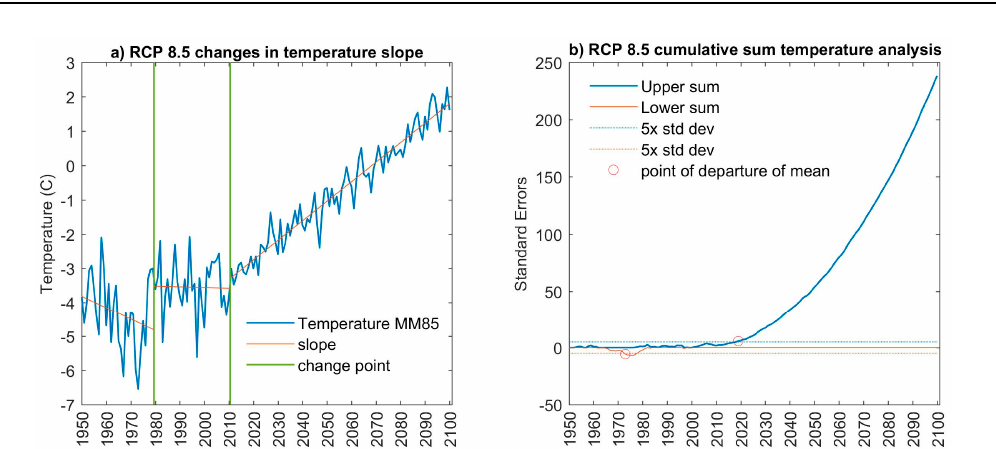
Figure 9. Illustration of temperature regime changes detected in the RCP 8.5 five-model mean (MM85) using: change point visualization ( a ); and cumulative sum analysis ( b ).